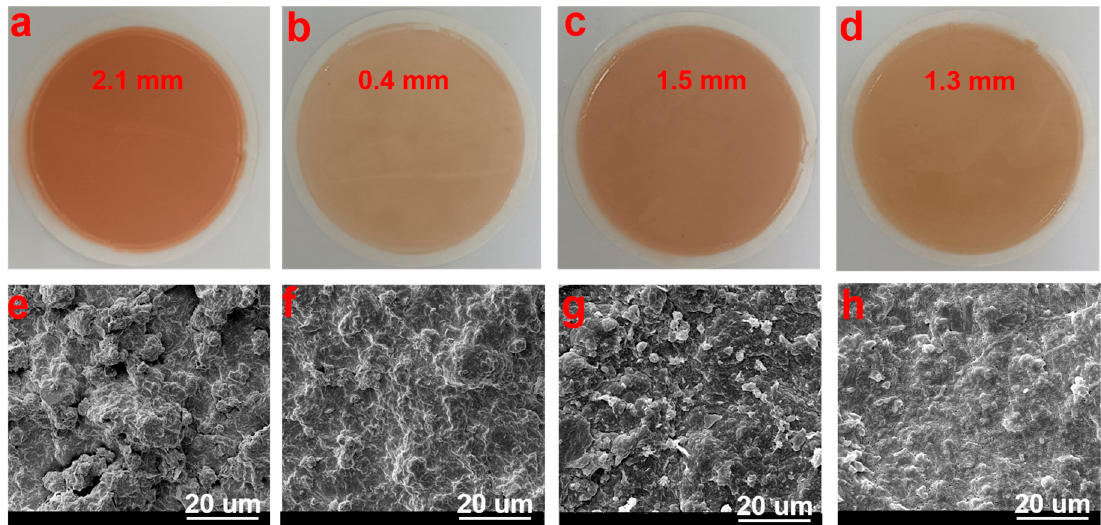
Figure 6. Digital images of mud cakes deposited from different WDFs after aging at 200 °C for 16 h: ( a ) 4% bentonite, ( b ) 4% bentonite + 2 wt% DDAM, ( c ) 4% bentonite + 2 wt% DDAM + 5 wt% NaCl, ( d ) 4% bentonite + 2 wt% DDAM + 36 wt% NaCl. SEM micrographs of dried filter cakes deposited from different WDFs after aging at 200 °C for 16 h: ( e ) 4% bentonite, ( f ) 4% bentonite + 2 wt% DDAM, ( g ) 4% bentonite + 2 wt% DDAM + 5 wt% NaCl, ( h ) 4% bentonite + 2 wt% DDAM + 36 wt% NaCl.